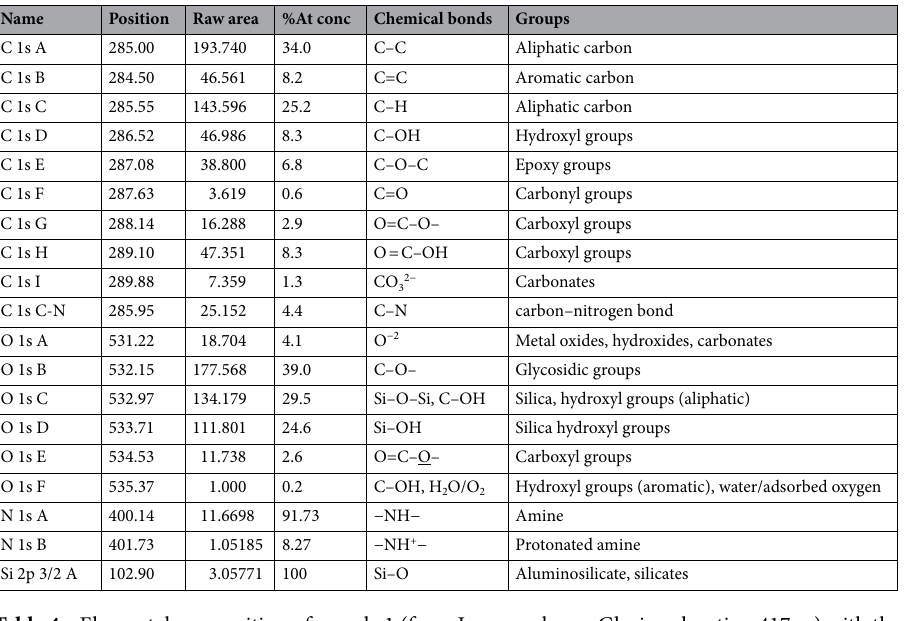
Table 4. Elemental composition of sample 1 (from Longyearbreen Glacier, elevation 417 m) with the identification of characteristic chemical bonds 35–38 determined by XPS.